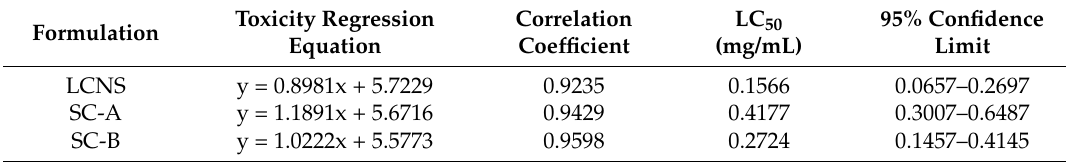
Table 3. Bioassay of three lambda-cyhalothrin